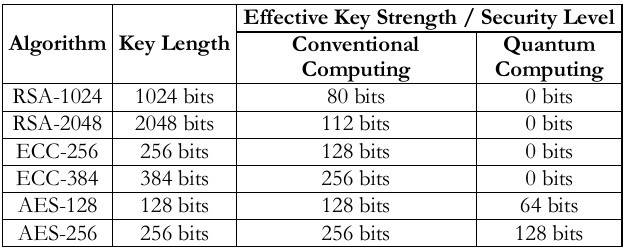
Table 2: Comparison of conventional and quantum security levels of typical ciphers